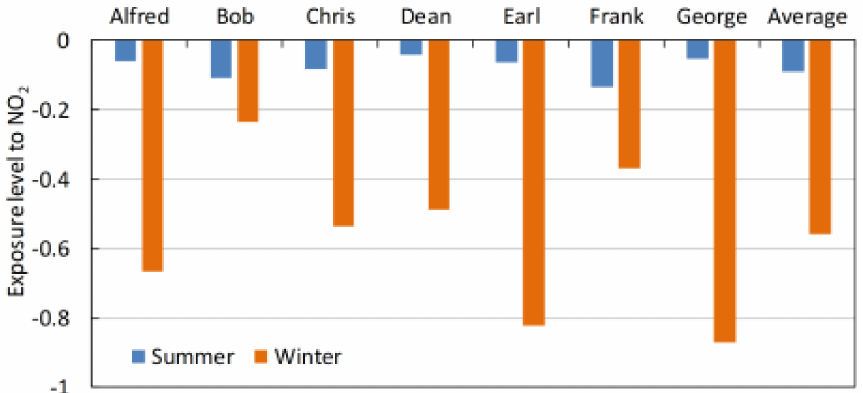
Figure 9. Individual and average normalized exposures to NO 2 for summer and